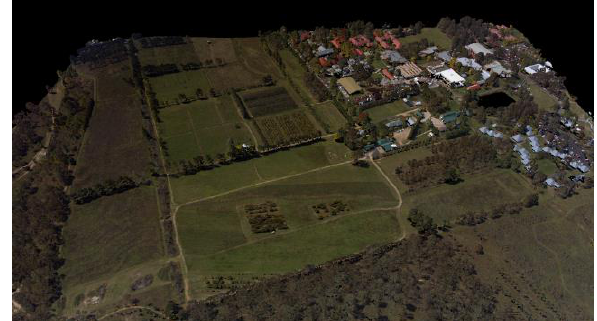
Figure 11. Colourised LiDAR point